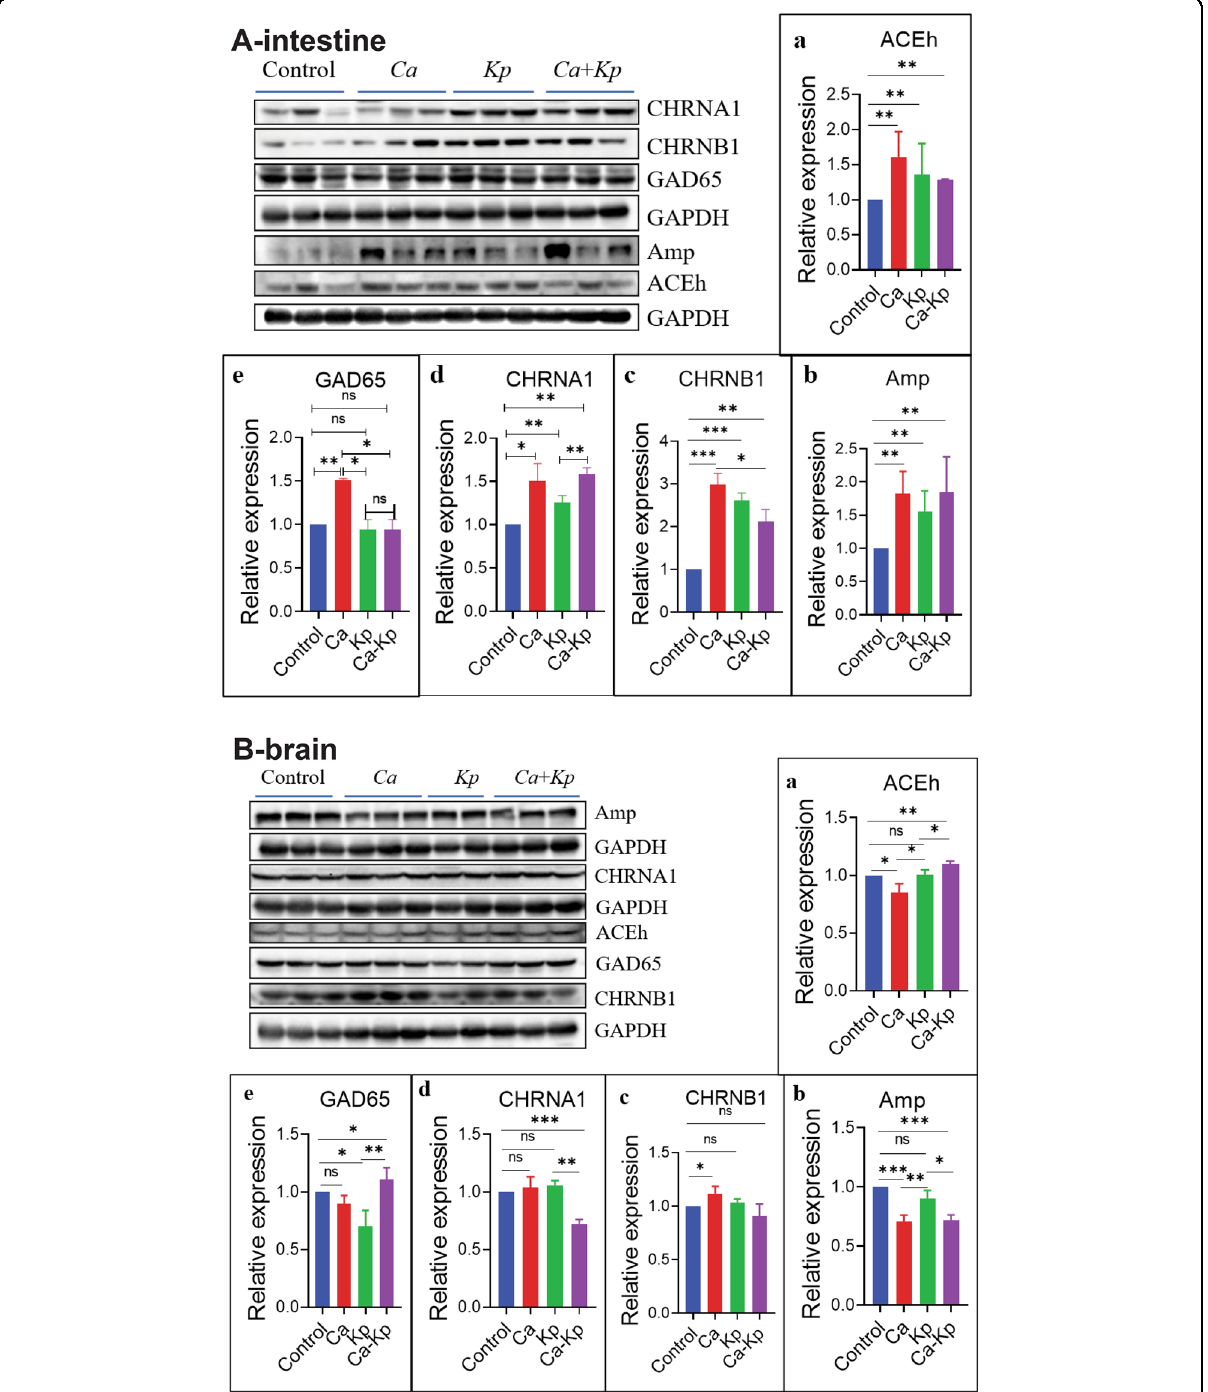
Fig. 9 C. albicans and Klebsiella pneumoniae in fl uence the cholinergic system in mice. A Expression of AChE, AMP, CHRNA1, CHRNB1, and GAD65 were changed in the intestine ( A , p < 0.05) and brain ( B ). Data are the mean ± SD of three independent experiments. * p < 0.05 and ** p < 0.01 vs. the model group by one-way ANOVA, followed by the Holm – Sidak